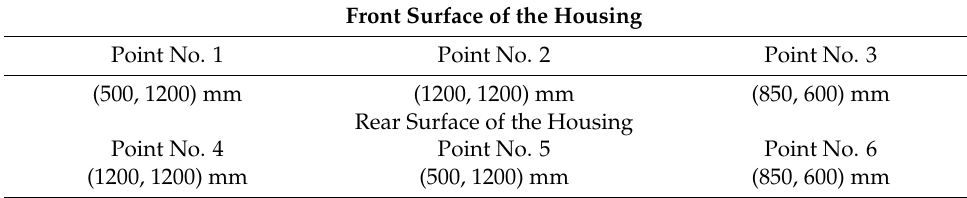
Table 1. Coordinates of measuring points (x,